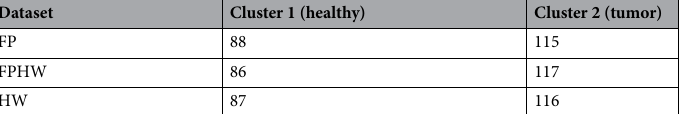
Table 5. Number of spectra in each class for k-means on full dataset (n = 203). This remains consistent over multiple re-runs of the algorithm.